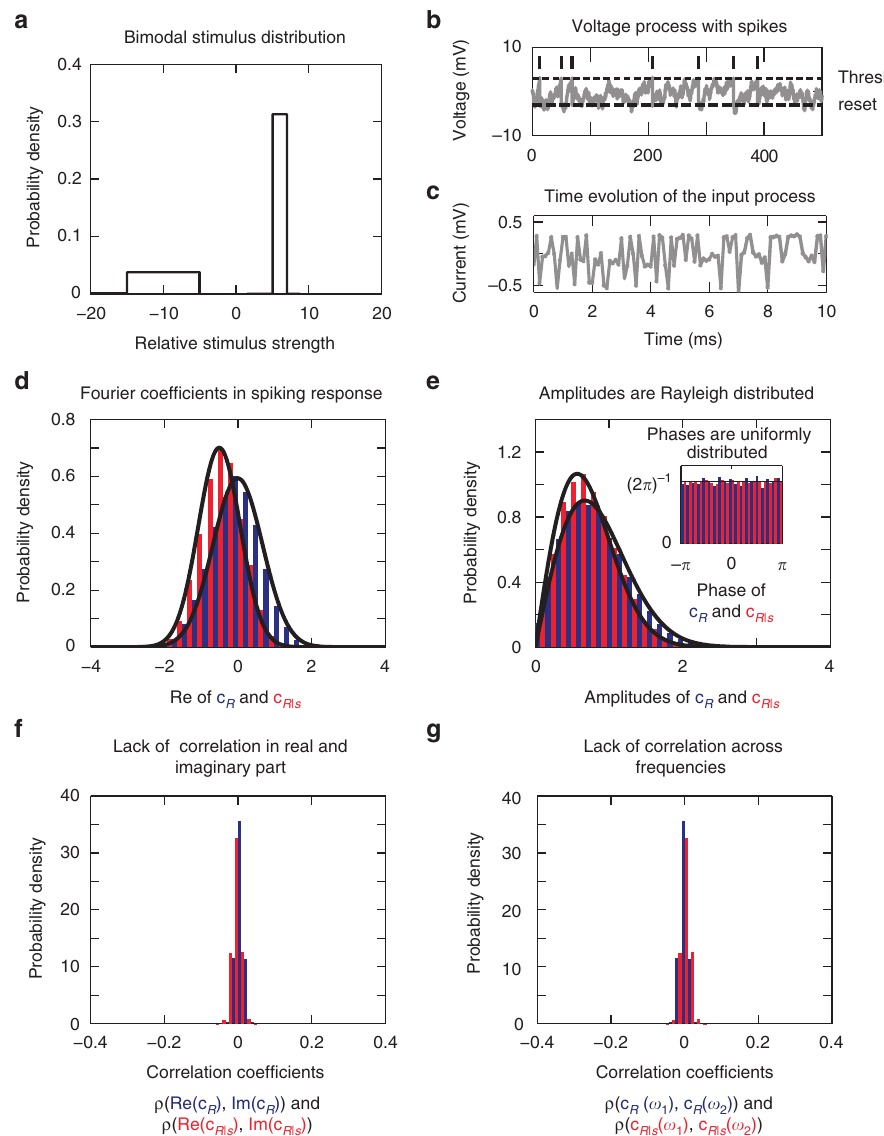
Figure 2 | Distribution of the Fourier coefficients in a leaky integrate-and-fire neuron evoked by bimodal stimuli. ( a ) Bimodal stimulus distribution from which a stimulus value is drawn at each time step. ( b , c ) The resulting spike train of a leaky integrate-and-fire neuron and the underlying stimulus trajectory, respectively. Firing rate is 11.8Hz and the corresponding mean interspike interval is 81ms. ( d ) Probability distribution of Fourier coefficients c R ( o ) (blue) and c R|s ( o ) (red) from spiking responses in c for a frequency f ¼ 11Hz ( o ¼ 2 p f ). It is noteworthy that the real part of Fourier coefficients c R is zero mean (blue), whereas c R|s have a non-zero mean (red). The non-zero mean does not affect the information content. ( e ) After the transformation of the mean- corrected Fourier coefficients to polar coordinates, we find that the amplitudes of c R and c R|s are Rayleigh distributed, whereas the phases are uniform ( e inset). Black lines denote the respective fits. In f we confirm that the real and imaginary part for each frequency between 1 and 500Hz are uncorrelated, as mathematical proofs indicate. ( g ) Similar lack of correlation holds across different frequencies ( D f ¼ 1Hz), whose residual non-zero values are due to finite recording size and decay with increasing recording time. Parameter values as in Table